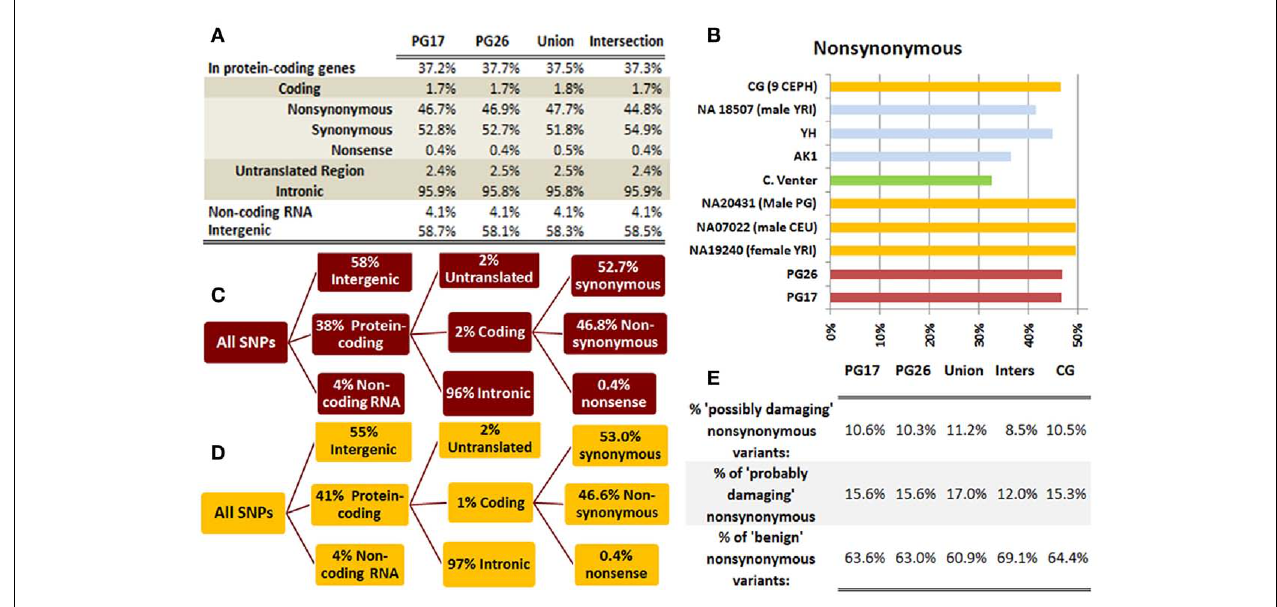
SNPs inVenter (green), AK, CH, andYRI (blue) are from publications (see TableA2 in Appendix for references). (C,D) Compare the distribution of SNPs locations and role in PG17 and PG26 (brown) and nine whole genome sequences generated at Complete Genomics (orange). (E) Provides a summary of the predicted impact of coding SNPs in PG17, PG26, their union and intersection, and the summary in nine Caucasians genotyped at complete genomics and annotated in the same way as PG17 and